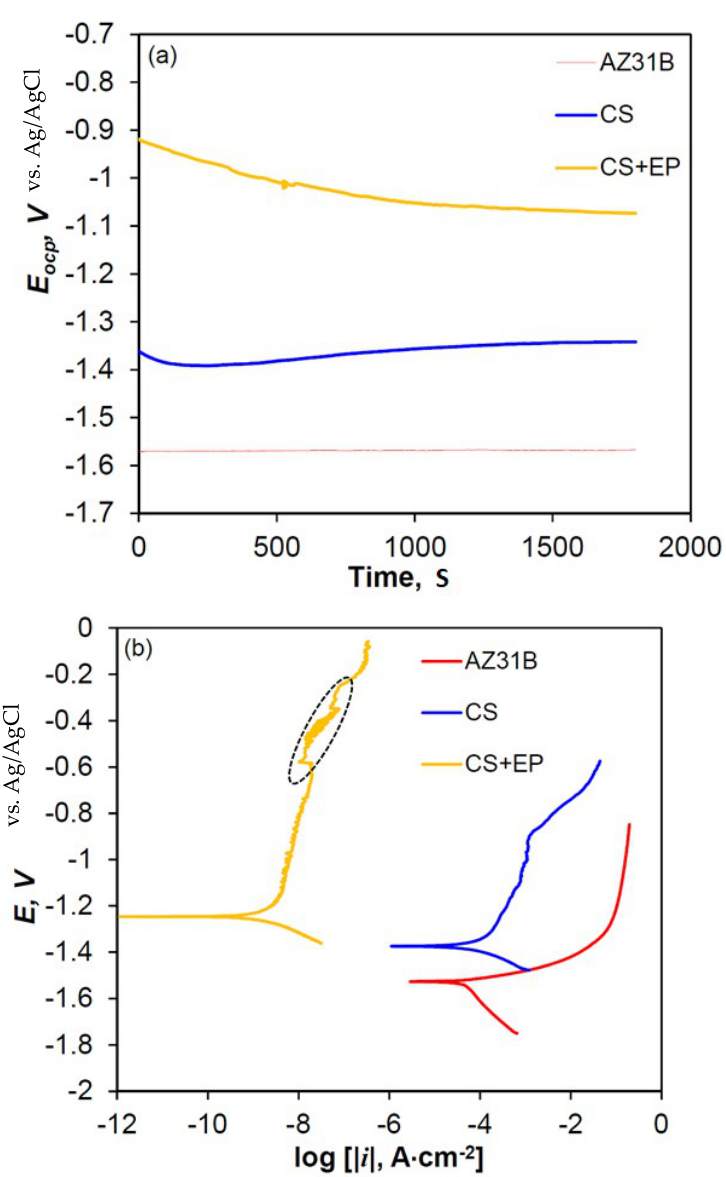
Figure 5. The ( a ) Open circuit potential (OCP) and ( b ) polarization curves of uncoated, CS AA7075 coated and CS + EP coated AZ31B specimens.